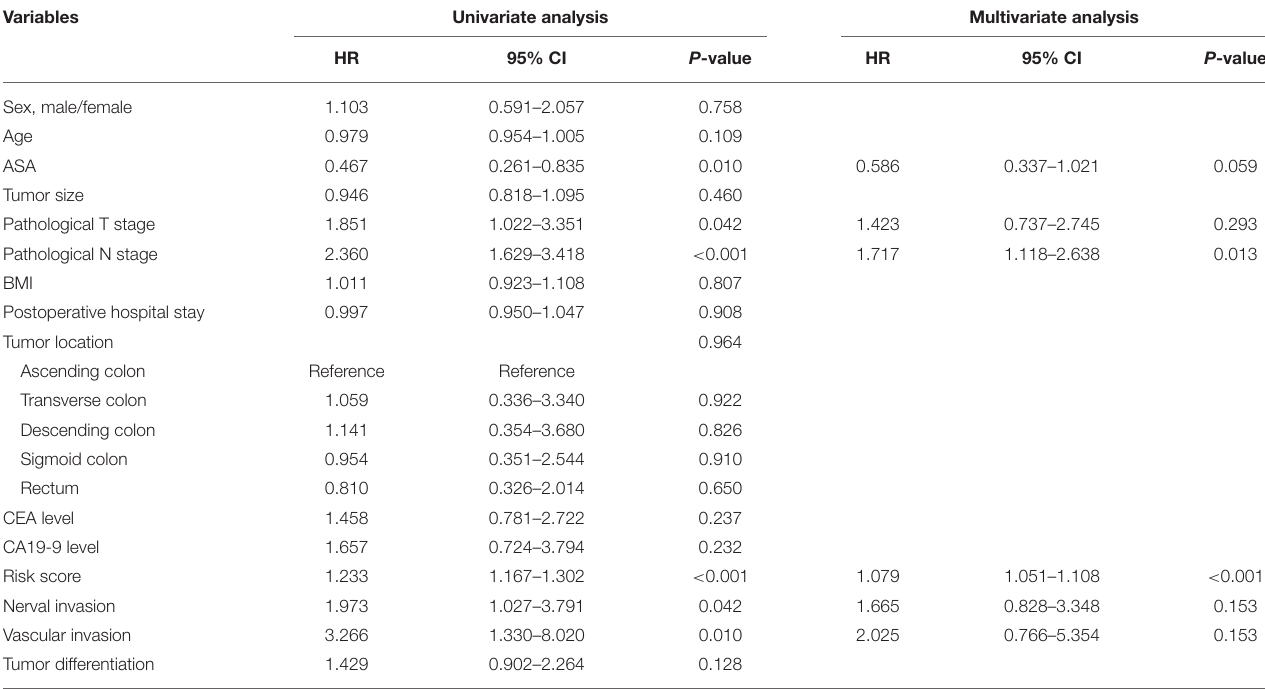
TABLE 2 | Cox regression analysis of predictive factors for disease-free survival in colorectal cancer (CRC) patients ( n = 136).